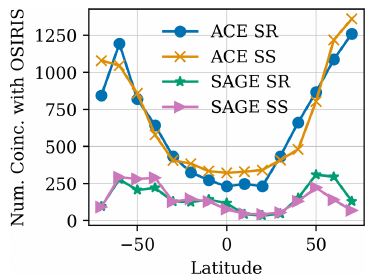
Figure 6. Number of coincident profiles in each 10 ◦ latitude bin for ACE-FTS and SAGE III/ISS with OSIRIS at 25.5km. SS refers to sunset occultations, while SR refers to sunrise